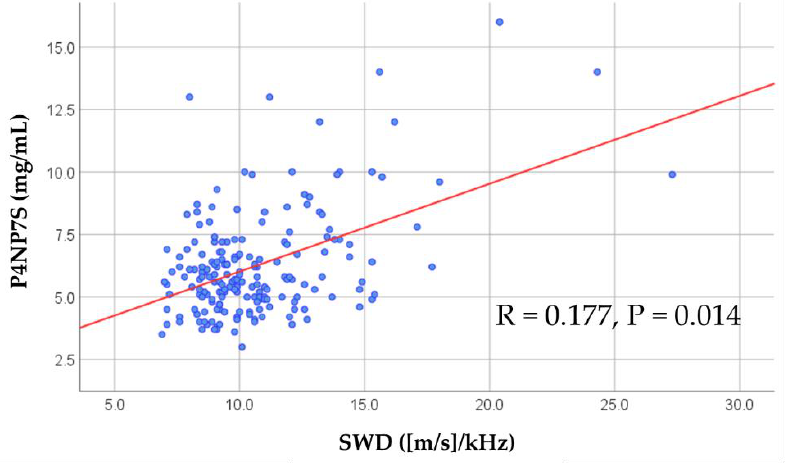
Figure 2. Correlation between SWD and P4NP 7S. SWD indicates shear wave dispersion and P4NP 7S indicates 7S domain of collagen type IV.